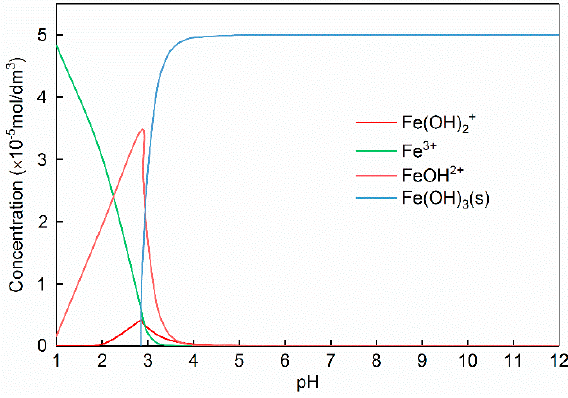
Figure 8. Distribution diagrams of ferric ions as a function of pH (Ferric ion: 5 × 10 − 5 mol / dm 3 ).